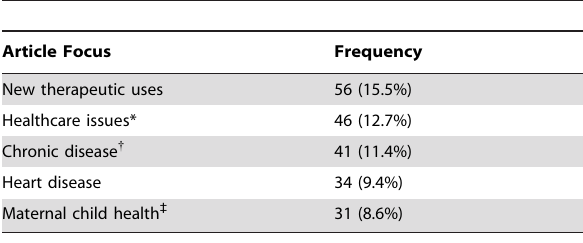
Table 2. Primary focus of 361 articles published in JAMA 1990, 2000,